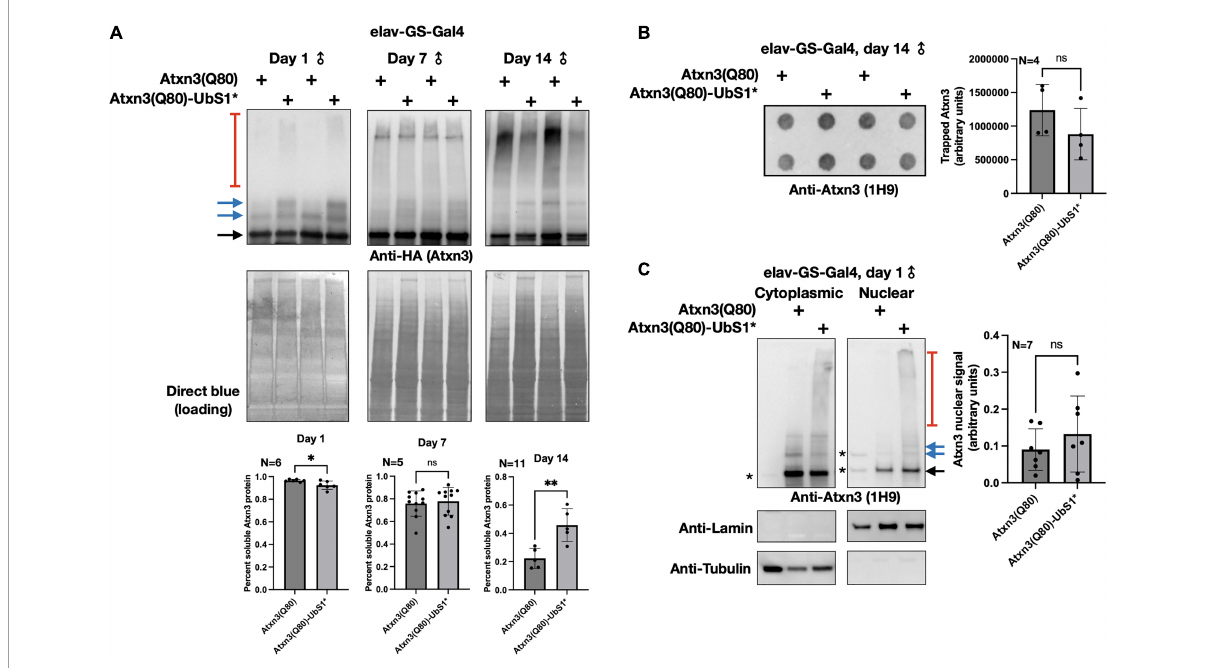
FIGURE2 Aggregation of Atxn3(Q80) with intact or mutated UbS1. (A) Top: Western blots of Atxn3 versions noted in the figure. Black arrow, main Atxn3 band. Blue arrows, ubiquitinated Atxn3. Red bracketed line, SDS-resistant species of Atxn3. Each lane is an independent repeat. Bottom: Quantification of signal from blots above and other independent repeats. ∗ p < 0.05, ∗∗ p < 0.01, “ns”, not significant. Statistics: t -tests. For quantifications, SDS-soluble species (black and blue arrows) were quantified separately from the SDS-resistant ones (red bracketed lines). (B) Left: Filter-trap assay using flies that express Atxn3(Q80) with an intact or mutated UbS1 in adult neurons for 14 days. Right: Quantification of results from the left as well as other, independent repeats. “ns”, not significant. Statistics: t -test. (C) Left: Results from biochemical separation of Atxn3 protein fractions in cytoplasmic and nuclear compartments when Atxn3 was expressed in adult fly neurons (1 day in RU486). Asterisks, non-specific signal. Black arrow, main Atxn3 band. Blue arrows, ubiquitinated Atxn3. Red bracketed line, SDS-resistant Atxn3. Right: Quantification of the signal from the left and other, independent repeats. “ns”, not significant from t -test. The entire Atxn3 signal in each lane was used for quantifications. Tubulin and lamin served as loading controls for their respective